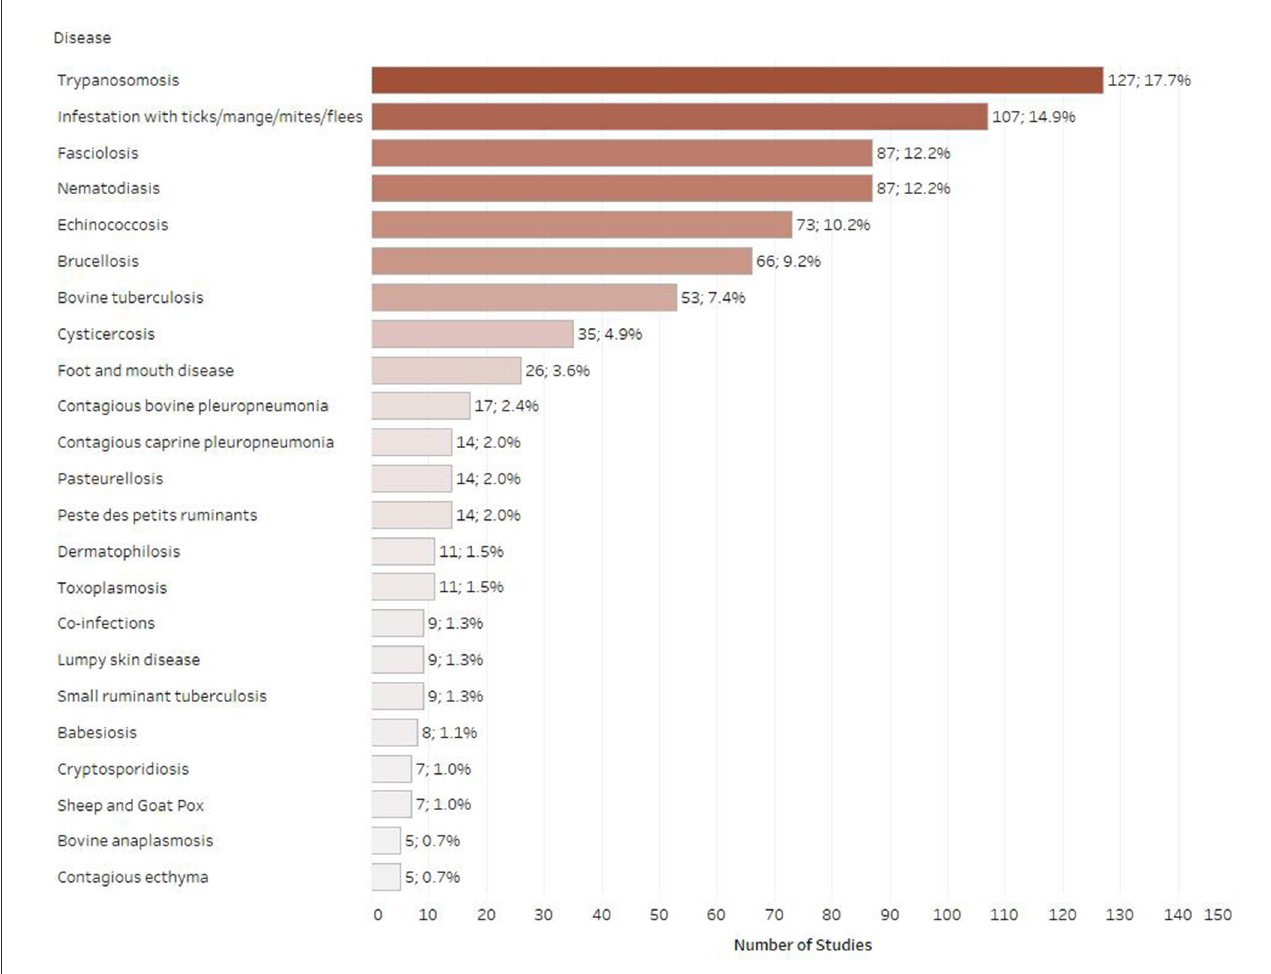
FIGURE6 Number of retrieved studies published on each disease (only diseases with five or more retrieved studies are displayed, some studies included multiple diseases).